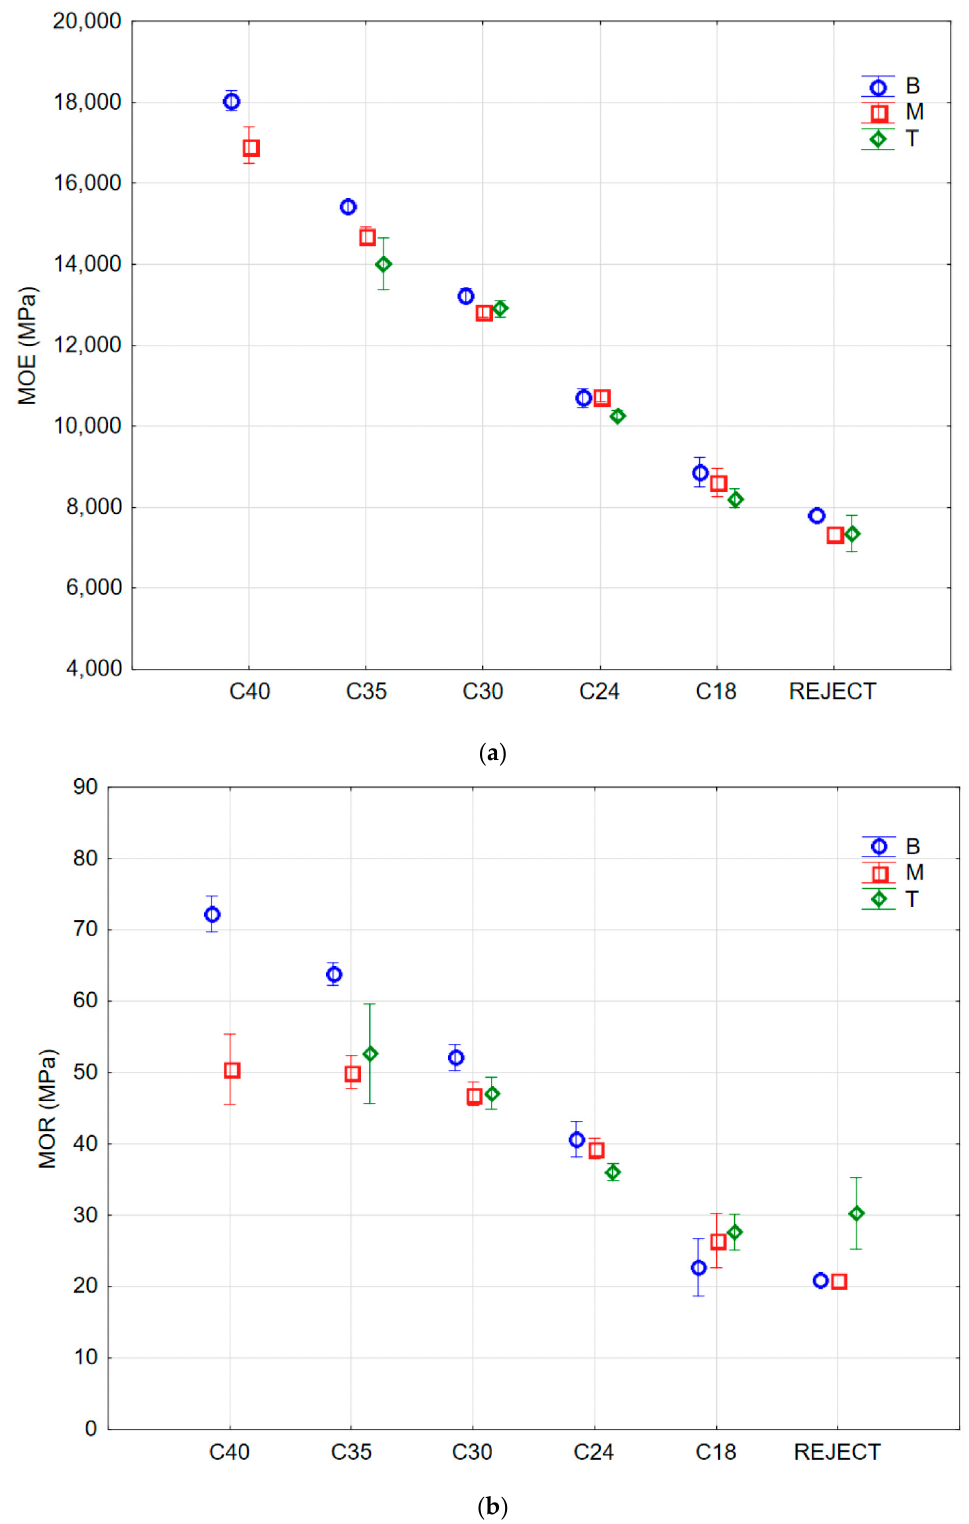
Figure 52. Plots of ( a ) Modulus of Elasticity (MOE) and ( b ) Modulus of Rupture (MOR) for logs of various grades (labelled C40 through to C18) of Scots Pine taken from various parts of the tree trunks (B, butt; M, middle; T, top). Data obtained using four-point bend experiments. From [169].